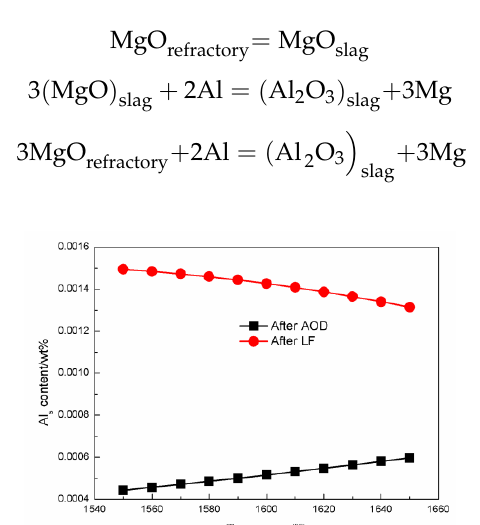
Figure 9. Effect of the slag on the content of Al s in steel.